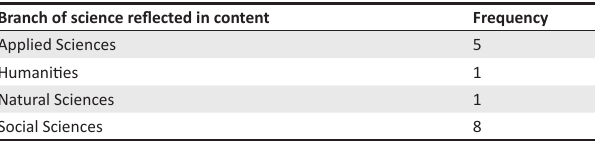
TABLE 2: Findings: